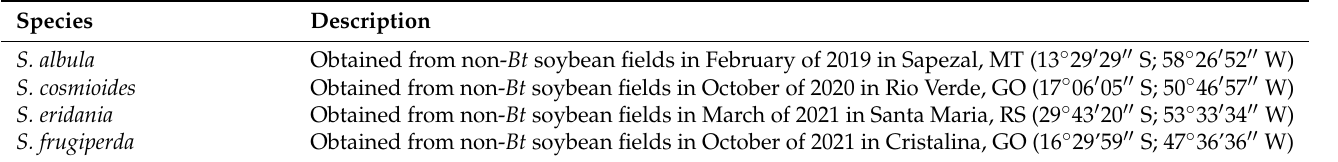
Table 1. Pest species tested in bioassays with Bt and non- Bt